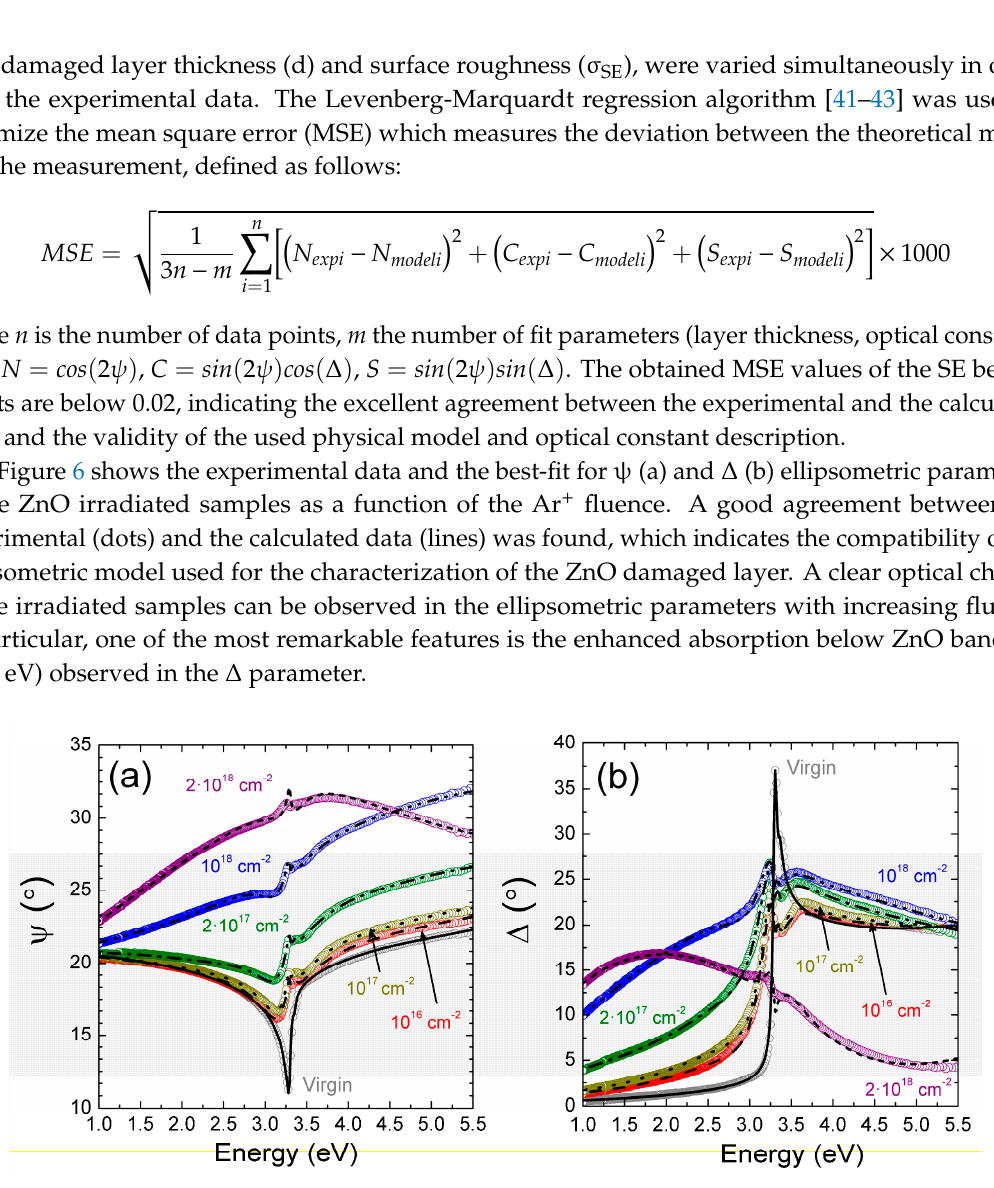
Table 1. Parameters obtained from the best fits of the SE model: roughness ( σ ), thicknesses of the damaged layer (d), high-frequency limit dielectric constant ( ε ∞ ), and energy of the critical point (E CPPB ). Errors in the last digit are indicated in parenthesis and correspond to the 90% confidence limits.